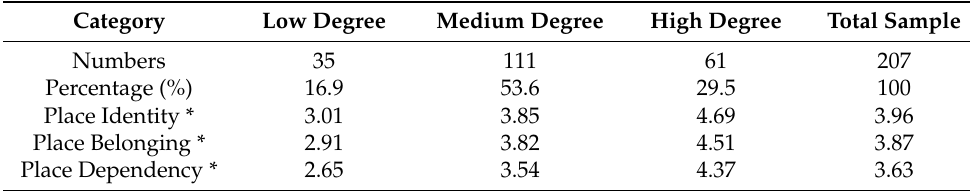
Table 6. Results of place attachment